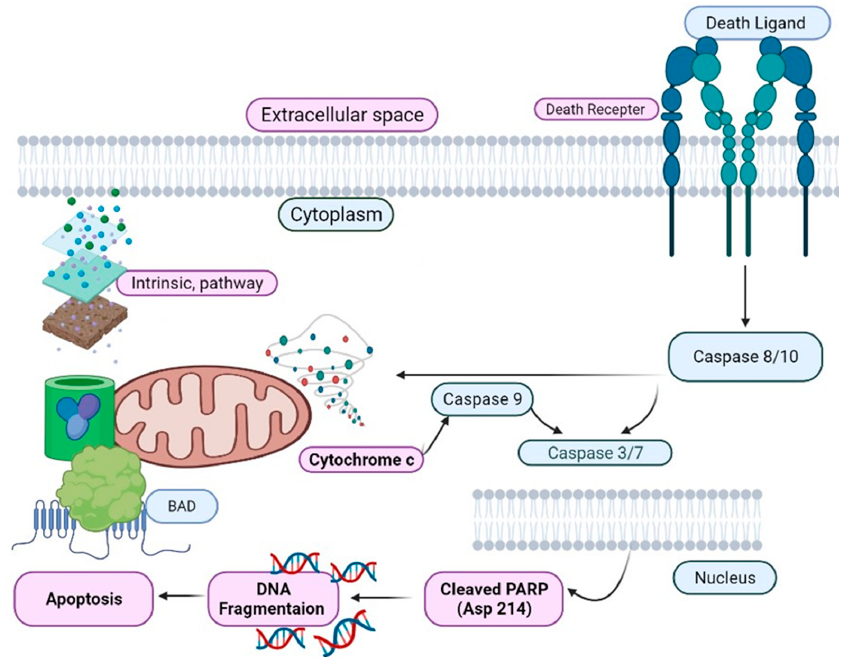
Figure 4. Expression of PARP via Caspase predicts good chemotherapy response and poor survival for patients with TNBC. Table 1. Structures and efficacy of PARP inhibitors currently under clinical evaluation for TNBC.